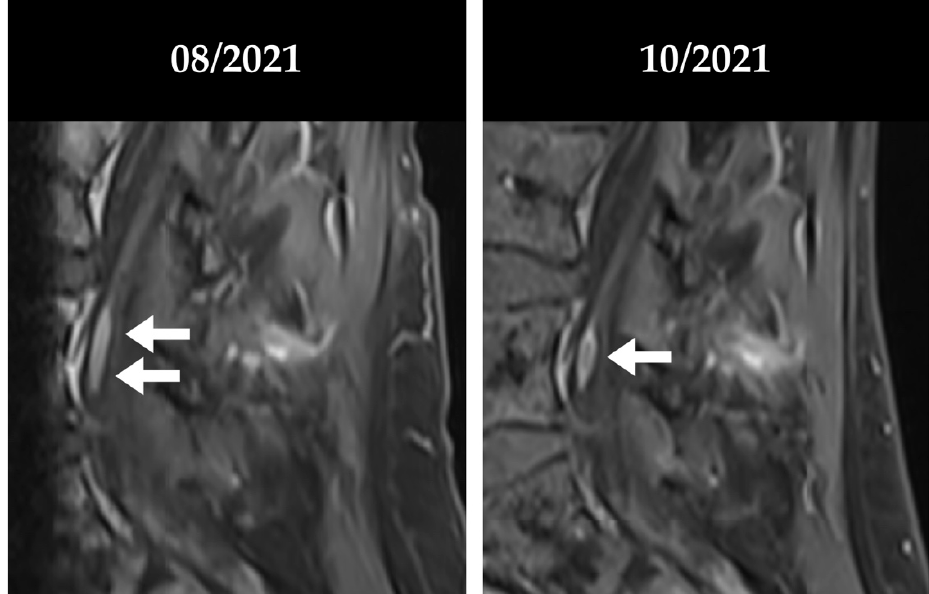
Figure 3. MRI scans of patient #1. Response to glofitamab. Left: T1 dixon sequence obtained 5 months after CAR T therapy demonstrating enhancement left S1 root (two white arrows). Right: T1 dixon sequence obtained around two months later, after initiation of glofitamab treatment revealing receding enhancement of the S1 root (one white arrow).